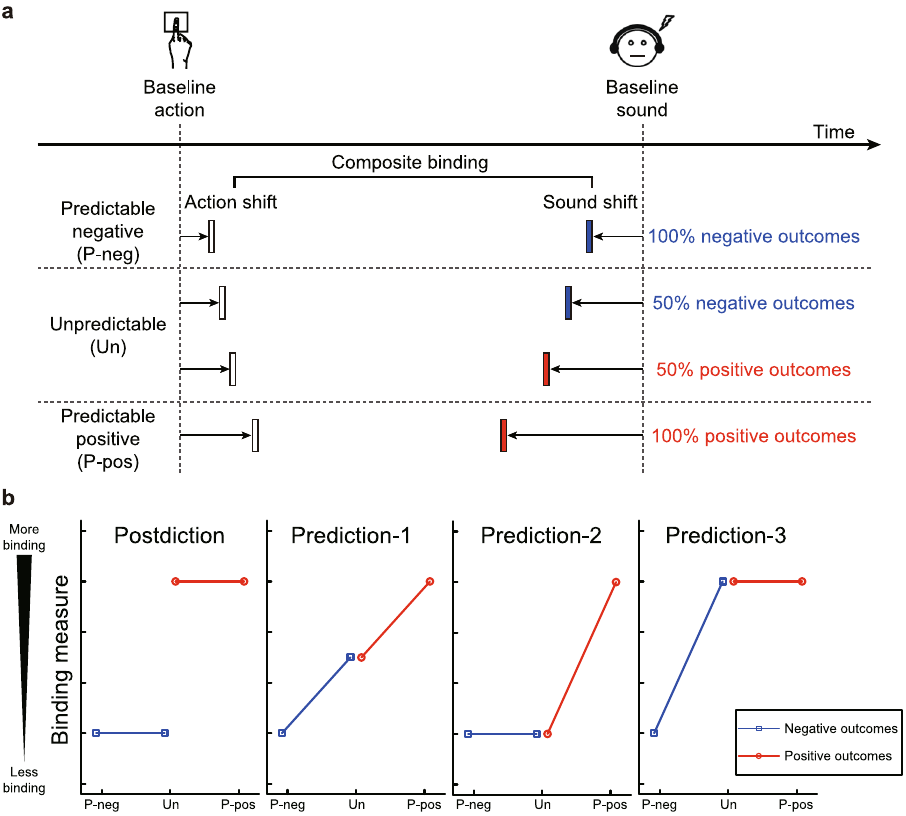
Figure 1. Experimental paradigm and hypotheses. ( a ) Intentional binding paradigm and the three emotional conditions. In each condition, the mean judgement error (i.e., difference between the judged and actual time of a corresponding event) in agency conditions was compared with that in single-event baseline conditions to calculate the action shift and the sound shift. We also calculated a measure of composite binding by combining the two. ( b ) Hypothetical results if the emotional modulation of SoA is postdictive (leftmost panel), and is predictive (other three panels). P-neg = predictable negative condition; Un = unpredictable condition; P-pos = predictable positive